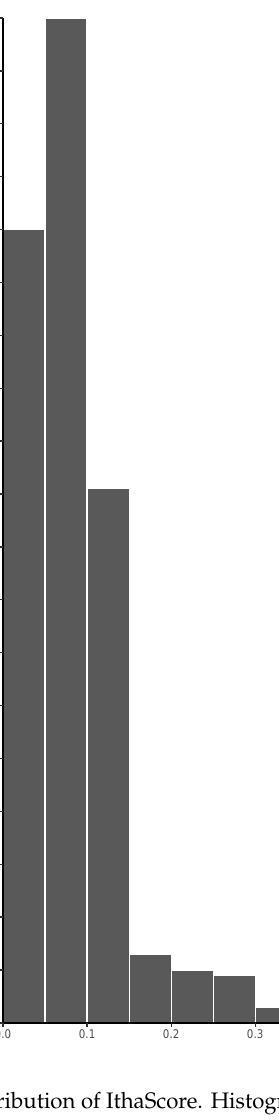
Figure 3. Distribution of IthaScore. Histogram shows the distribution of IthaScore in the range 0–1 for 483 gene-phenotype interactions. Table 2. The gene with the highest IthaScore for each phenotype. “Phenotype ID” column indicates the identifier assigned to each phenotype throughout this work.